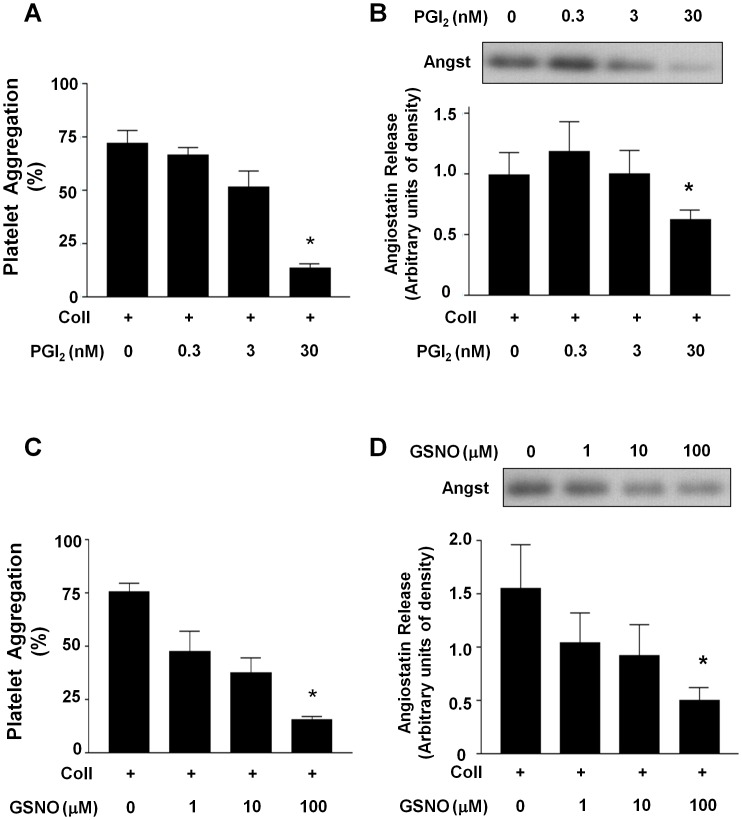
Effect of physiological platelet inhibitors on angiostatin release.(A) Summary data demonstrating the concentration inhibitory effects of PGI2 on platelet aggregation. (B) Representative immunoblot and summary densitometry data demonstrating the inhibitory effects of PGI2 on platelet angiostatin release. (C) Summary data demonstrating the concentration inhibitory effects of the nitric oxide donor GSNO on platelet aggregation. (D) Representative immunoblot and summary densitometry data demonstrating the inhibitory effects of GSNO on platelet angiostatin release. Collagen (3 µg/ml) was used to induce aggregation. N = 5. *, P<0.05 vs. control. Angst – Angiostatin.